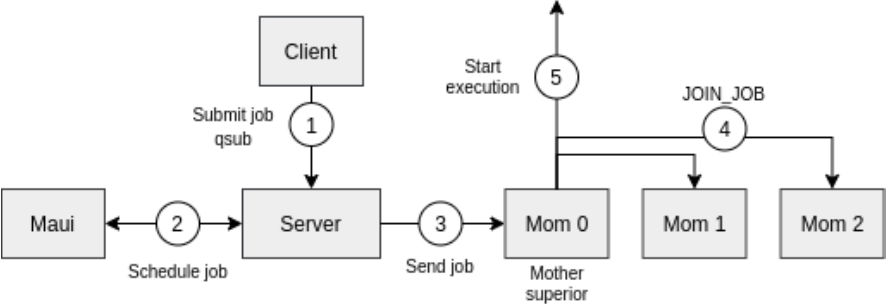
Figure 6. Charm++ and RMS—workflow of the Torque/Maui batch system [47]. Based on: http: //charm.cs.illinois.edu/newPapers/15-12/paper.pdf (accessed on 7 May 2022). Adapted with permission from [47]. Copyright 2014, Suraj